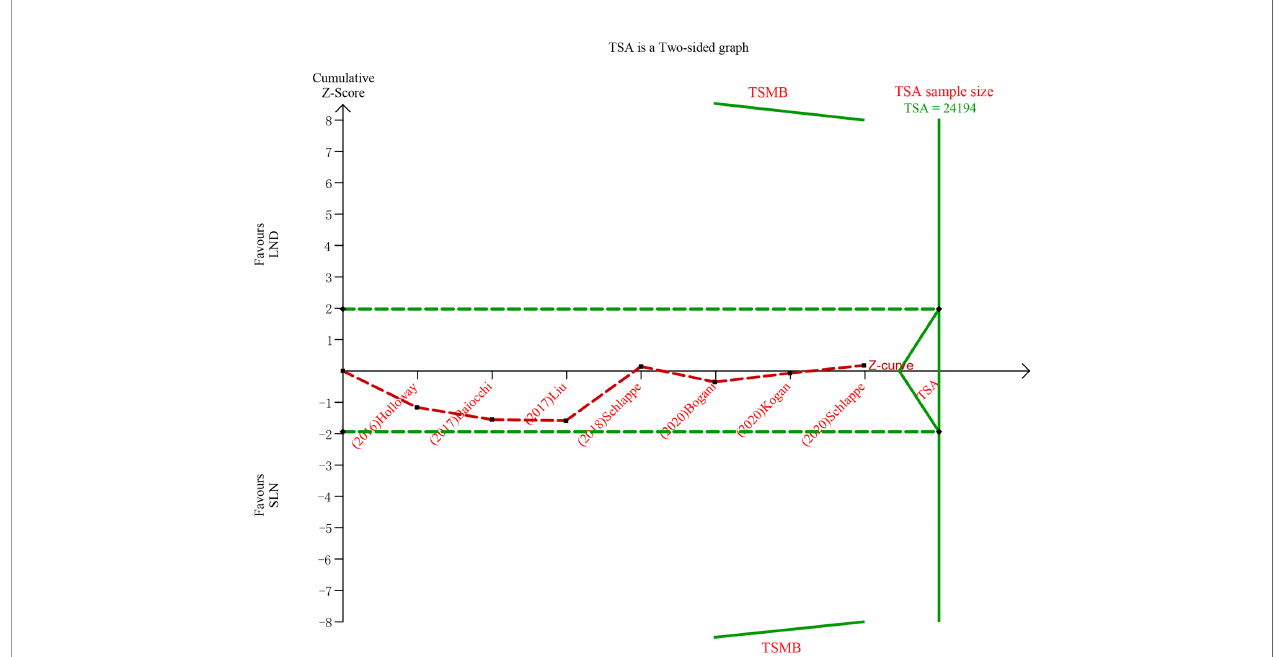
FIGURE 8 | TSA of para-aortic lymph nodes, a = 0.05, b = 0.8, relative risk reduction = 15.4%, incidence in control group = 9.2%, two-sided